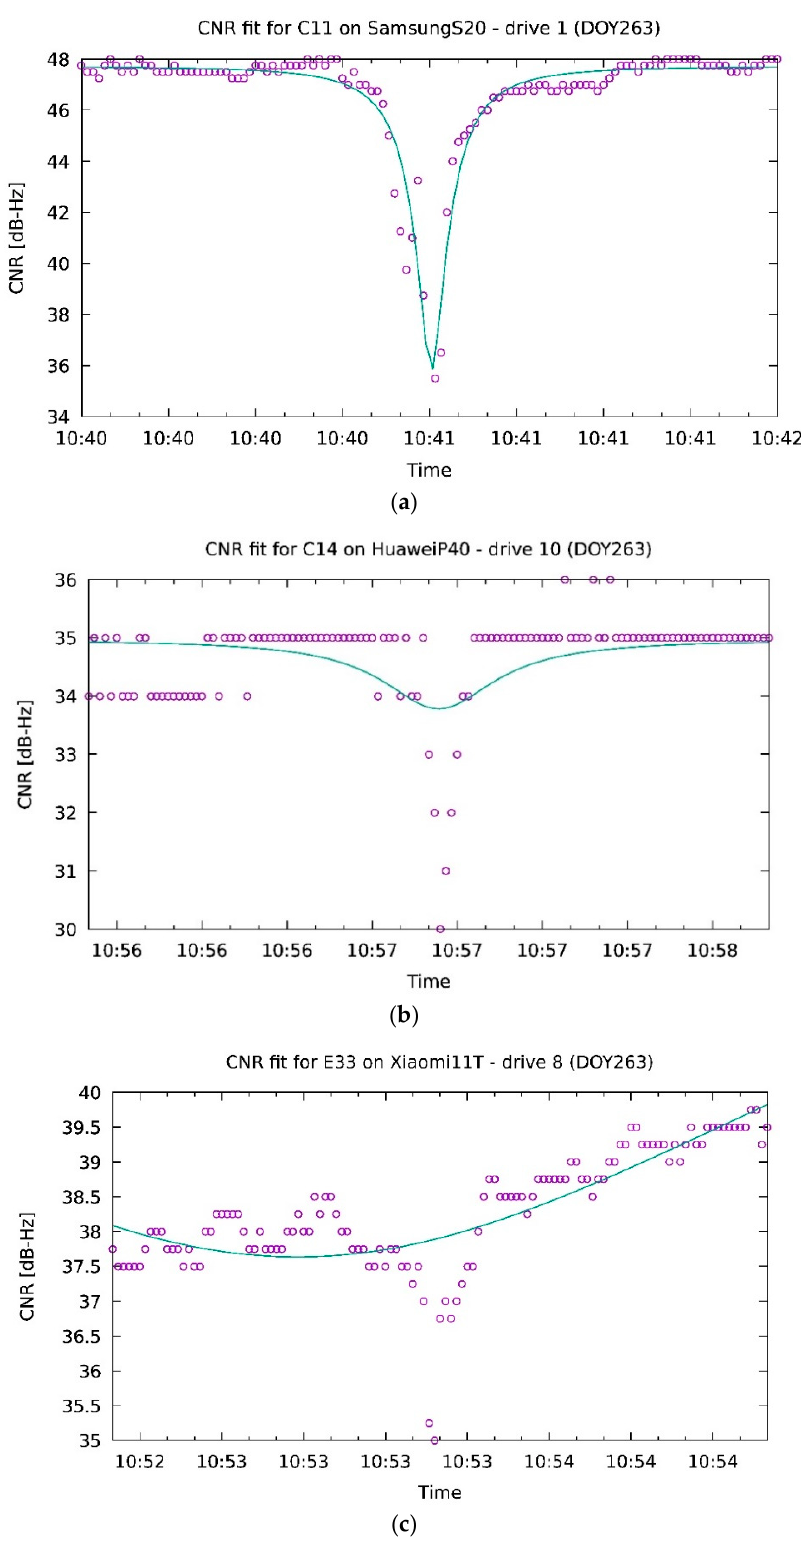
Figure 9 . Examples of CNR-fitting functions: ( a ) a good fit; ( b ) a bad fit due to a lack of measurements in the vicinity of the jammer; and ( c ) a bad fit due to the instability of the non-jammed CNR.